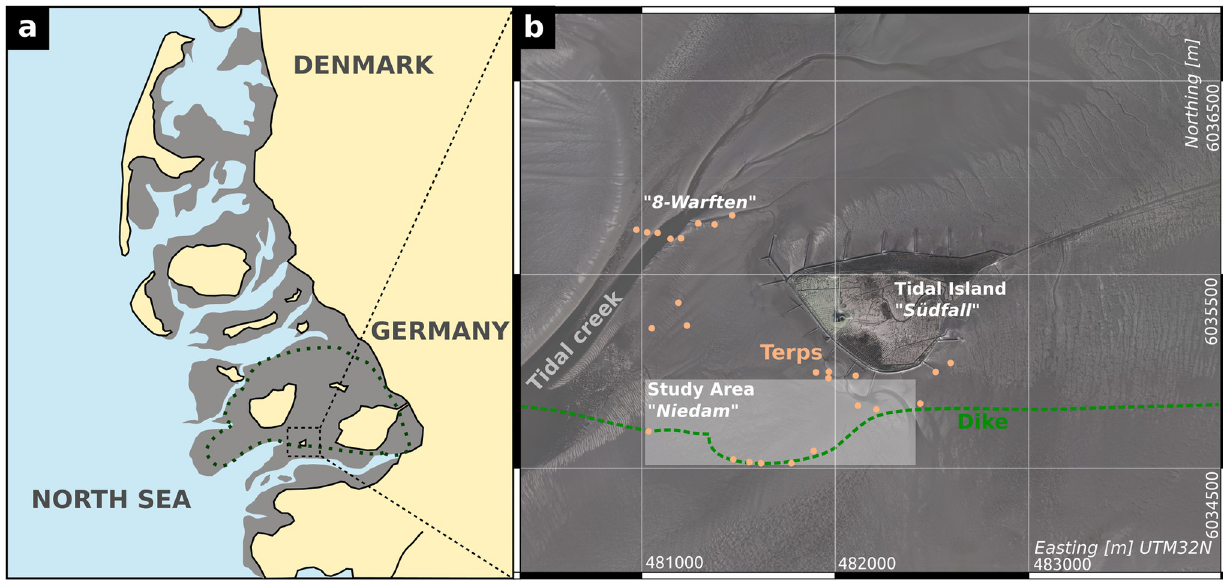
Fig 1. Study site map. a) Location of the study area at the North Sea coast of Germany. Grey areas show the tidal flats and yellow areas show the recent coastline, redrawn after [4]. The dashed line indicates an approximate model of the former coastline of the island Strand before the Marcellus flood 1362 AD. b) Aerial photo of the tidal island Hallig Südfall and surrounding tidal flats [5]. The white transparent box indicates the investigated site, named Niedam area , dots mark known archaeological findings recorded in the catalogue of the archaeological state department of Schleswig-Holstein. Aerial photos are a combination of photos 32480_6034, 32480_6036, 32482_6034, and 32482_6036, republished from Regional government authority for coastal preservation, national park and ocean protection (LKN) under a CC BY license, with permission from LKN, original copyright 2013.